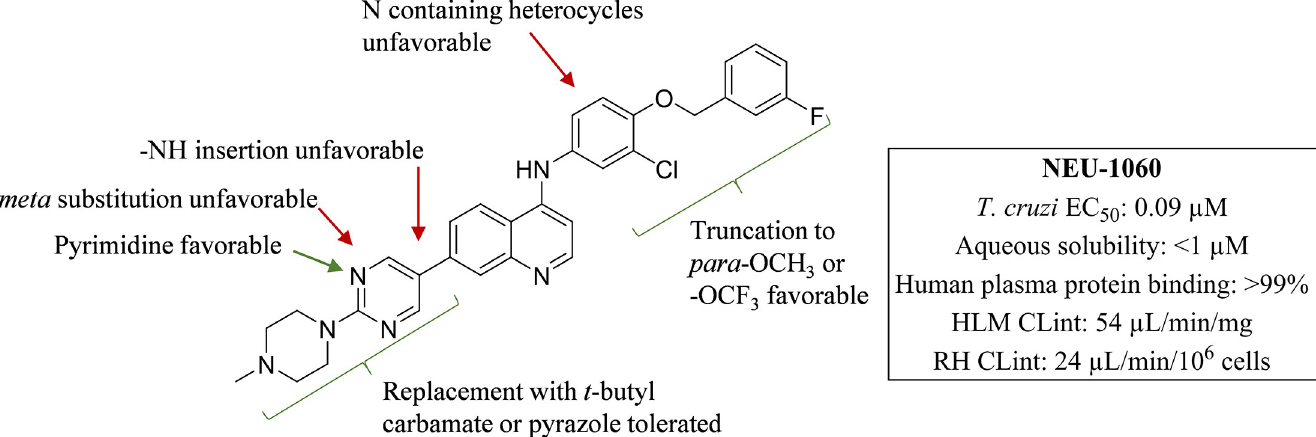
PLOS NeglectedTropical Diseases | https://doi.org/10.1371/journal.pntd.0006834 November26,